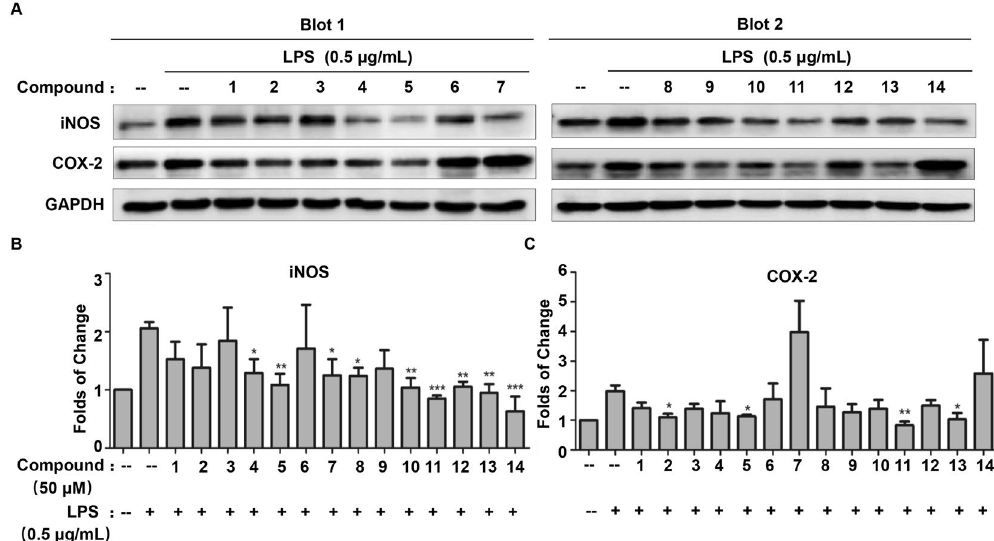
Figure 5. Effects of isolated compounds on LPS-induced iNOS and COX-2 expression in BV2 microglia cells. ( A ) Western blot analysis of iNOS and COX-2 expression. The cells were pre-treated with all compounds with the concentration of 50 μ M for 1 h, and subsequently incubated with 0.5 μ g/mL of LPS for 24 h. The expression of iNOS and COX-2 was detected by Western blotting and quantified by Image Lab software. ( B and C ) Quantification of iNOS and COX-2 induction (Panel A). Data were expressed as mean ± SD (n = 3) and analyzed by one-way ANOVA with Dunnett’s test for iNOS expression and LSD test for COX-2 expression. * p < 0.05; ** p < 0.01; *** p < 0.001. (Drug plus LPS vs